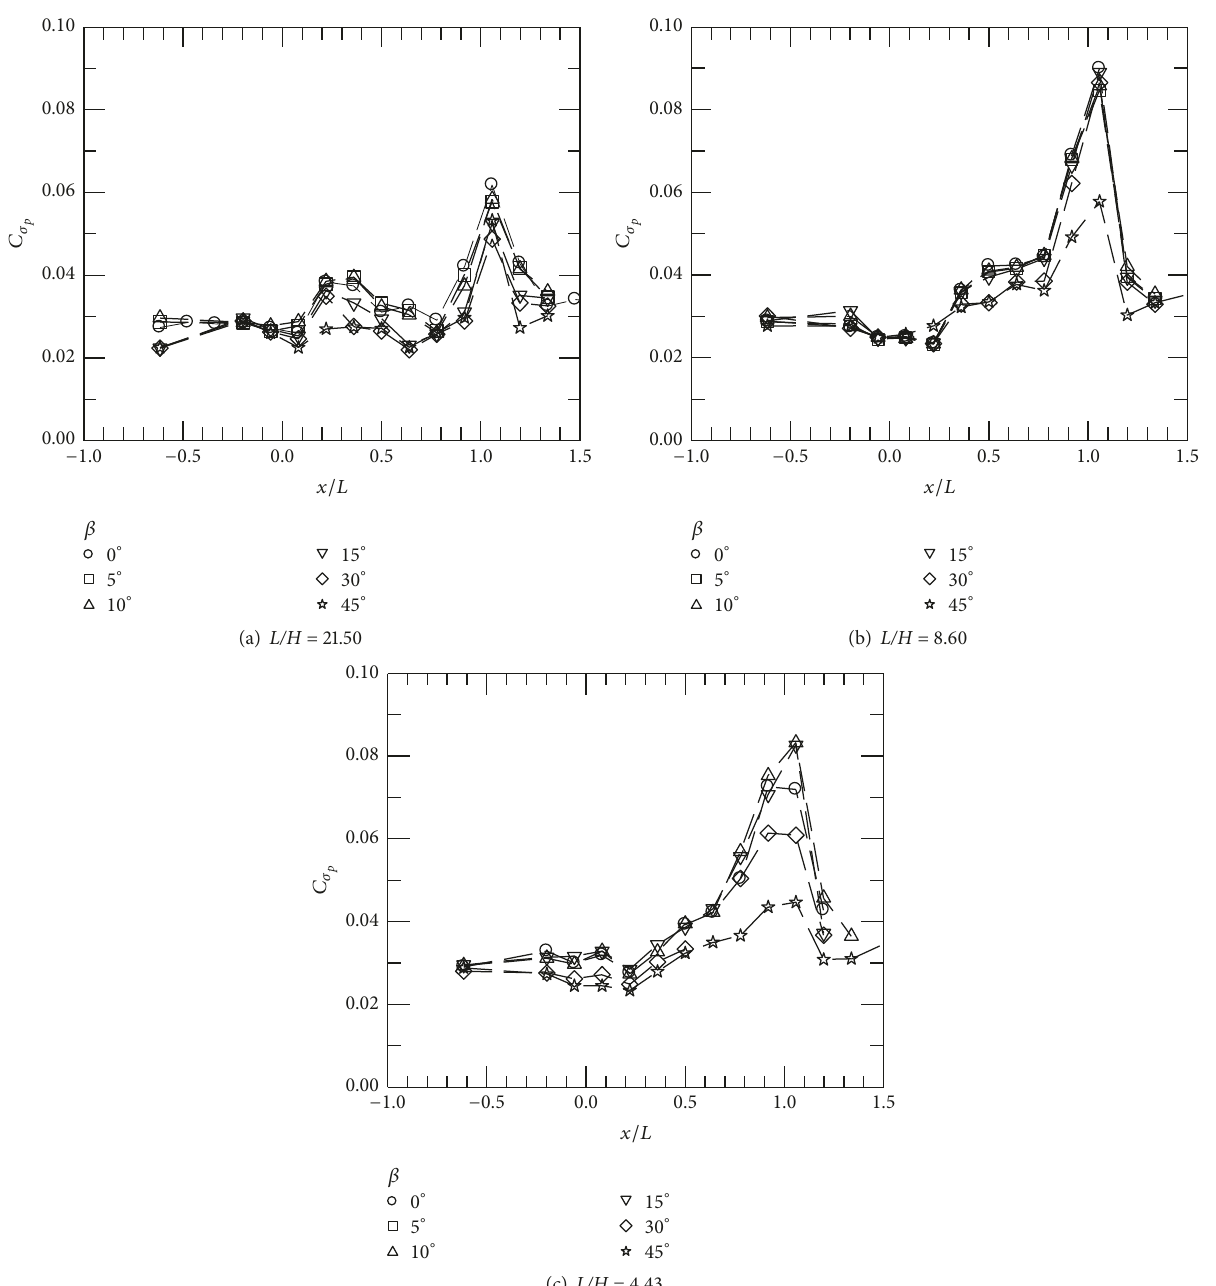
Figure 7: Chord-wise distributions of the surface fluctuating pressure for M = 0.83: (a) L/H = 21.50, (b) L/H = 8.60, and (c) L/H = 4.43.